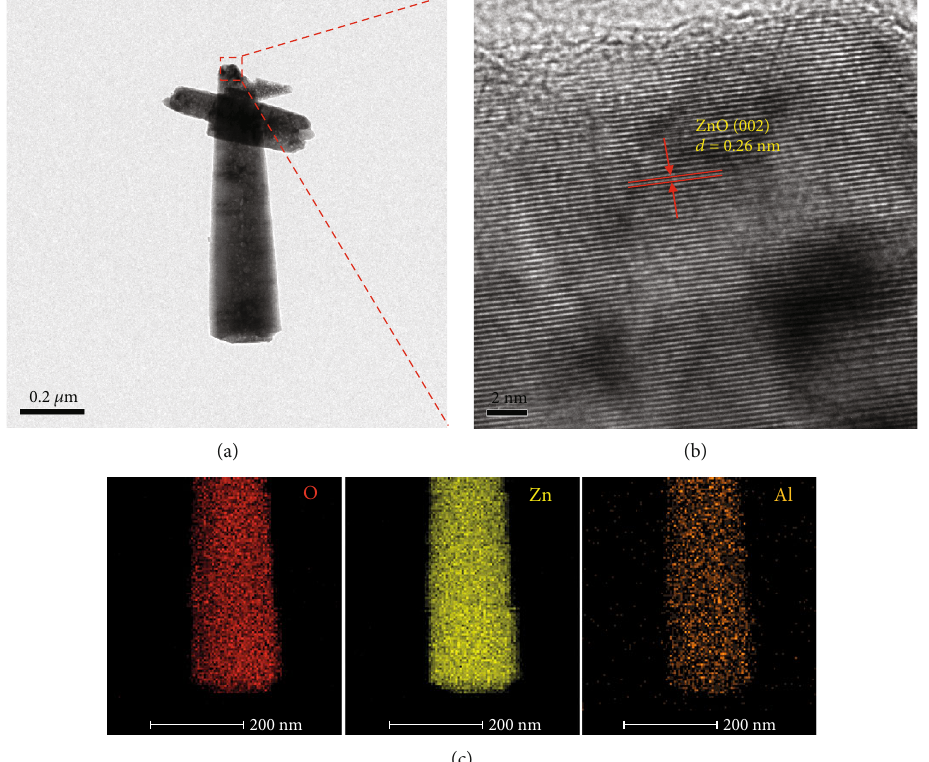
Figure 5: (a) TEM, (b) HRTEM, and (c) EDS elemental mapping images of the Al-doped ZnO sample with the Al 3+ /Zn 2+ ratio of 1 at% in the precursor